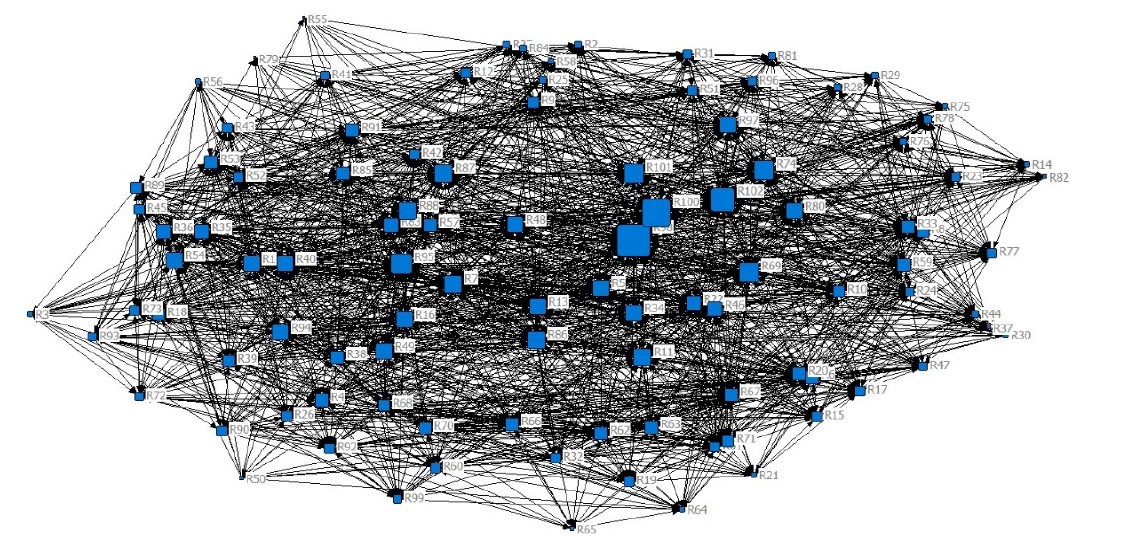
Figure 4. Relation among risks according to the degree of centrality.